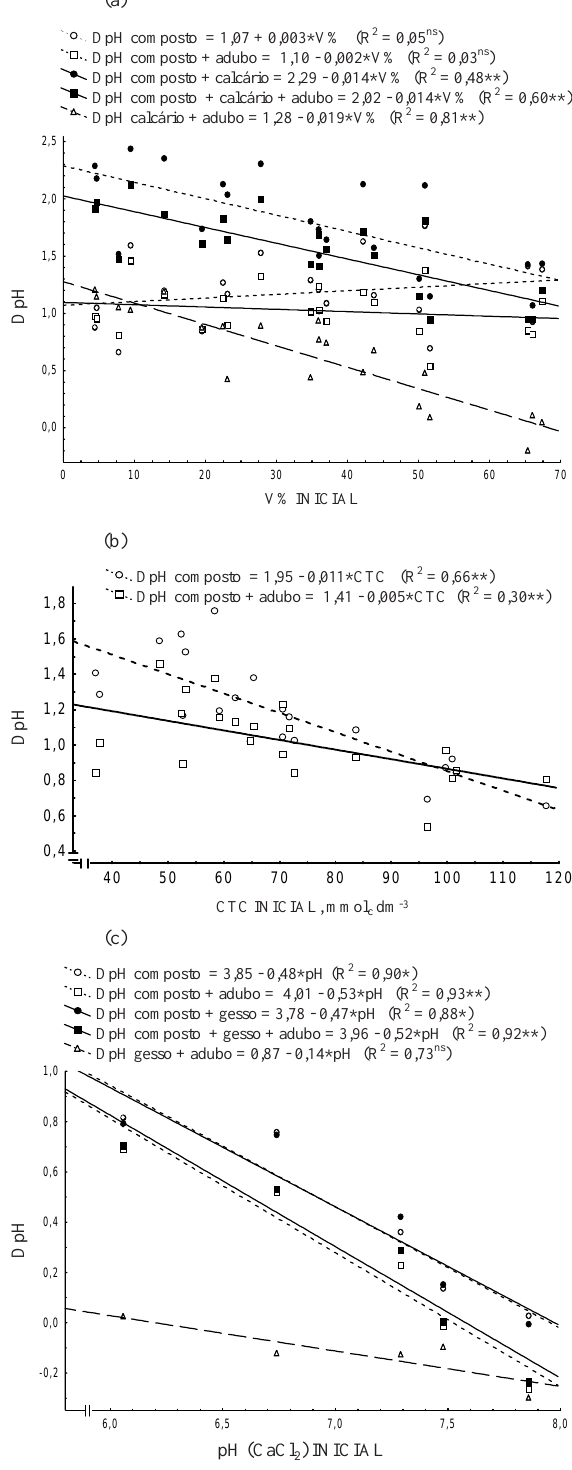
Figura 4. Relação entre o incremento do pH em (DpH) e saturação por bases (V%) (a) ou CaCl 2 CTC (b) iniciais em solos ácidos, tratados com composto de lixo na presença ou ausência de calcário dolomítico e adubos minerais, e pH em inicial em solos alcalinos, em que o CaCl 2 calcário foi substituído por gesso